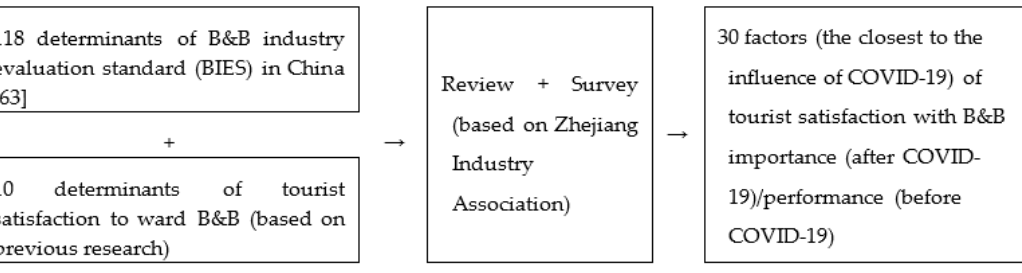
Figure 3. Logic of selection of the 30 questionnaire factors.